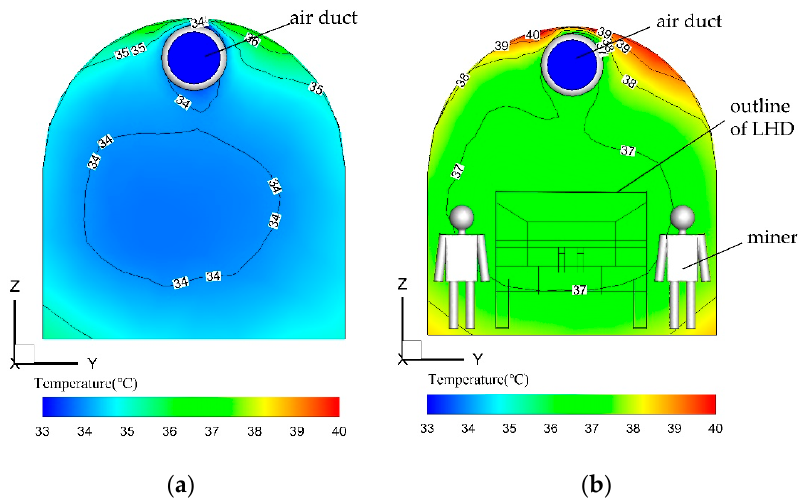
Figure 11. Airflow temperature distributions in the cross section of X = 14 m without and with LHD: ( a ) without LHD; ( b ) with LHD.